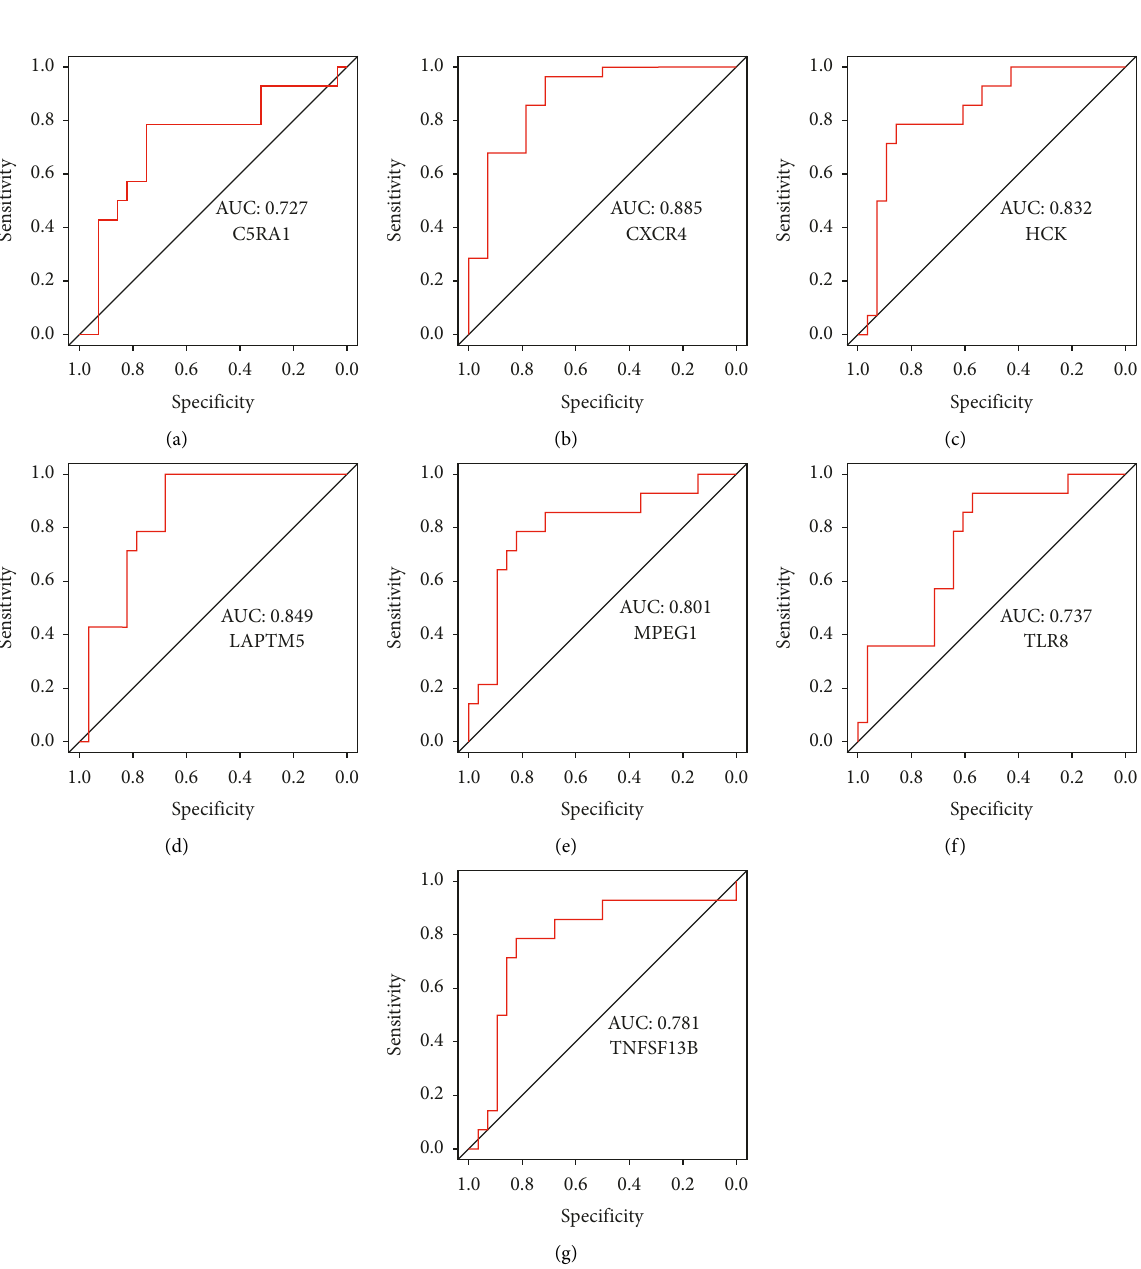
Figure 10: The receiver operator characteristic curves of the hub immune-related genes for atrial fibrillation. (a) C5RA1, (b) CXCR4, (c) HCK, (d) LAPTM5, (e) MPEG1, (f) TLR8, and (g)